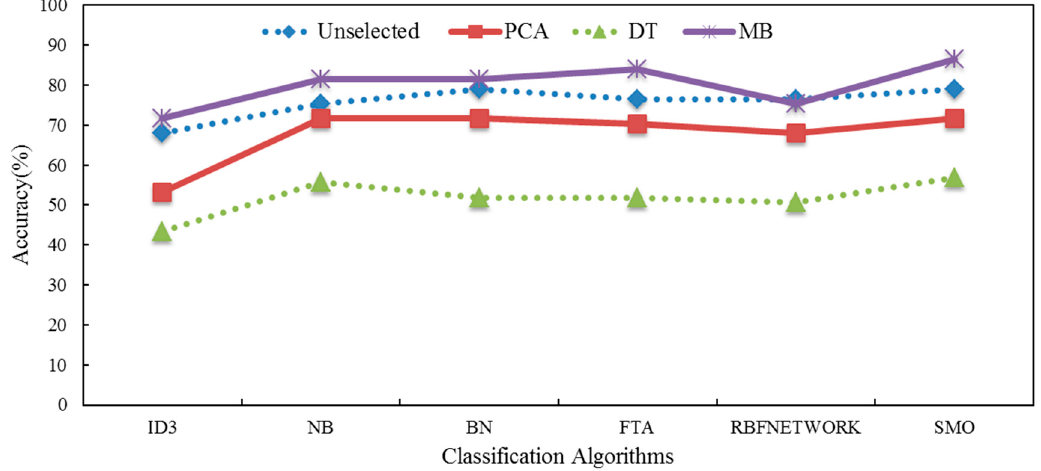
Figure 12. The evaluation of the classification algorithms.